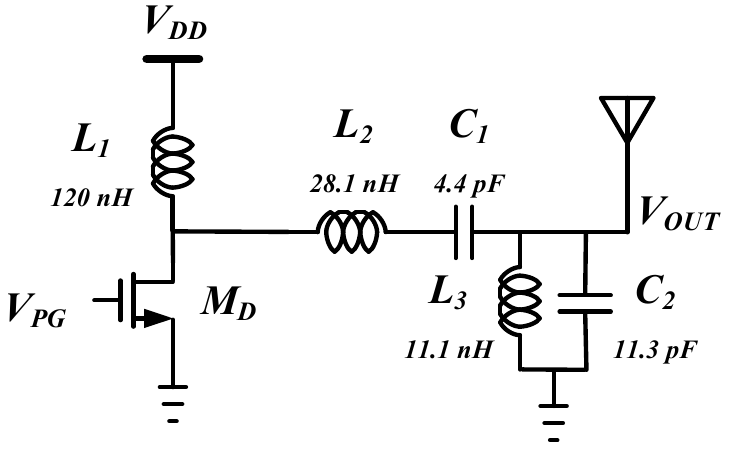
Figure 8. Schematic of the switching drive amplifier with off-chip LC pulse shaping filter.